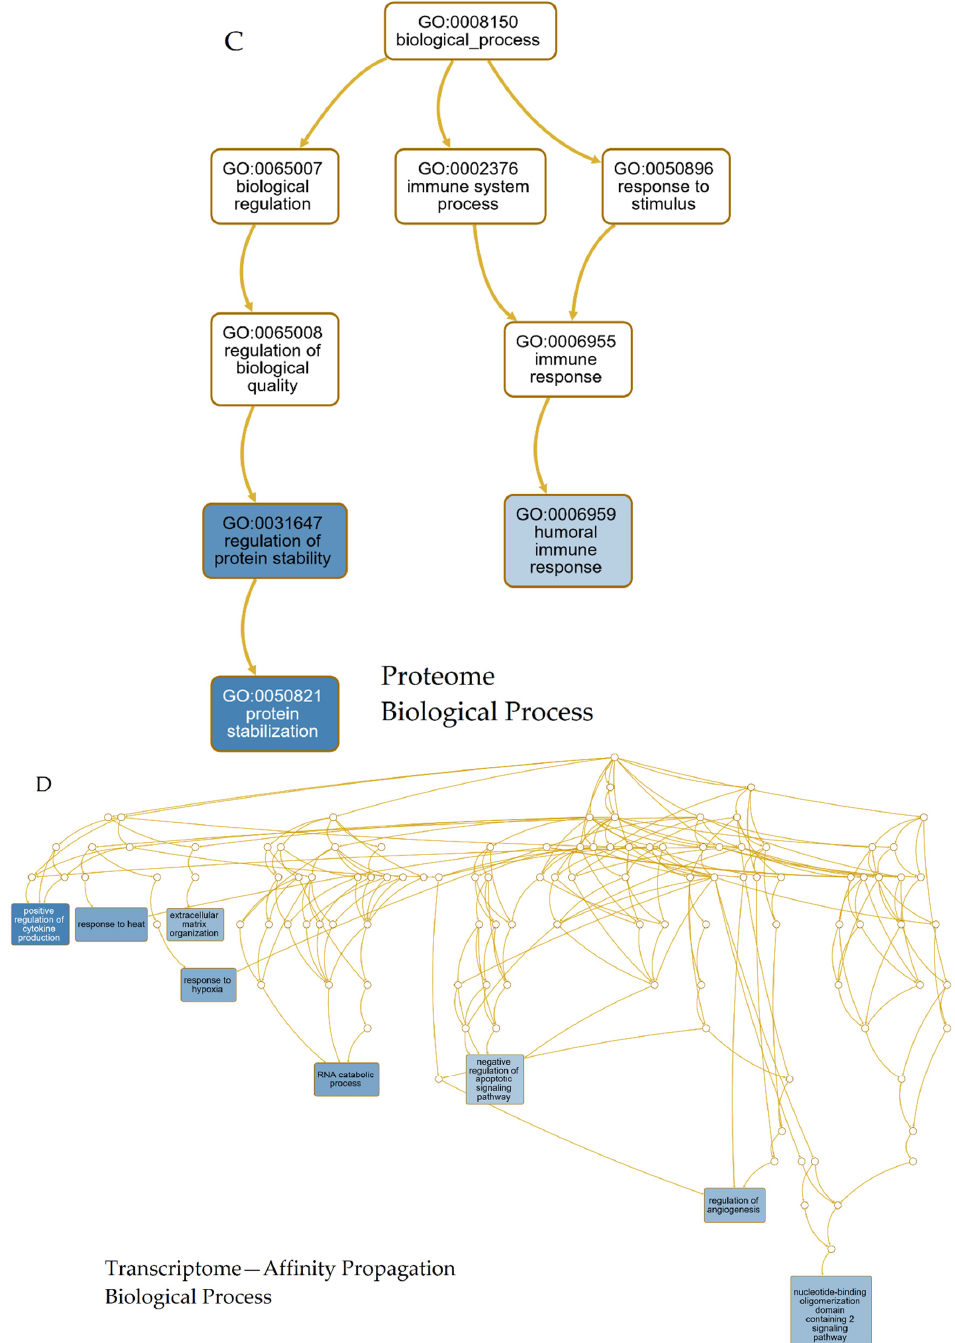
Figure 5. Directed acyclic graph showing the significant results (false discovery ratio (FDR) ≤ 0.05) of the GO-Term ORA of the Cellular Component and Molecular Function of the transcriptomic overlap of all four NDDs ( A , B ), the Biological Process terms of the proteomic data ( C ) and the Biological Process terms of the transcriptomic data after a ffi nity propagation ( D ). Blue shading indicates the value of the FDR. For better readability, all GO-Terms leading to the significant ones were hidden in ( A , D